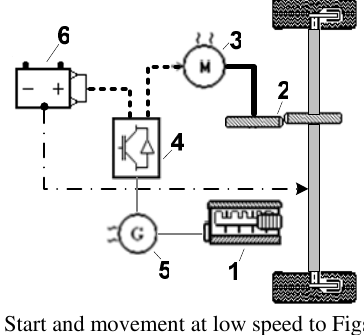
Fig 7. Start and movement at low speed to Figs 7–10: 1 – internal combustion engine; 2 – reduction gear; 3 – electric motor; 4 – commutator; 5 – generator; 6 – battery; on Figs: solid heavy lines indicate the way of torque, dash heavy lines indicate electric power way, dashdot lines-total